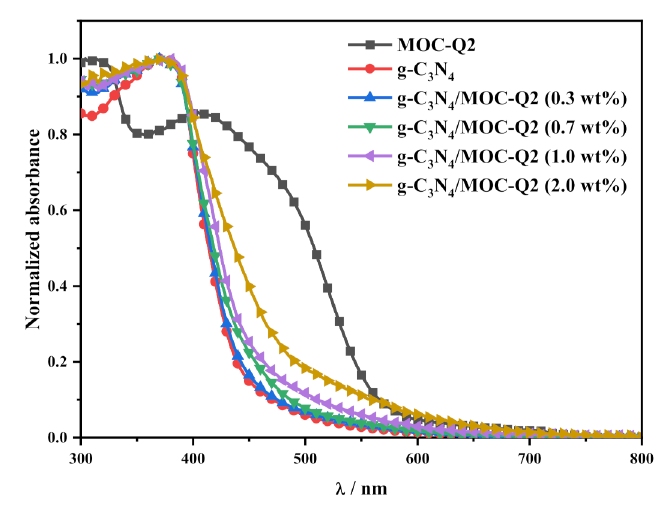
Figure 3. UV − VIS absorption spectra of g-C 3 N 4 , MOC-Q2, and g-C 3 N 4 /MOC-Q2 (0.3/0.7/1.0/2.0 wt%).